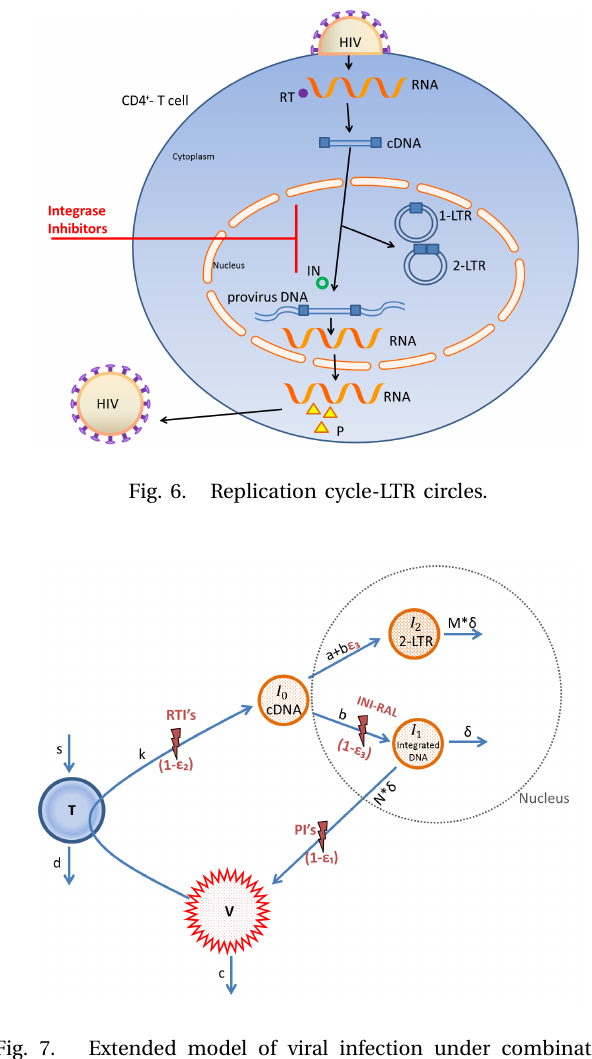
Fig. 7. Extended model of viral infection under combination